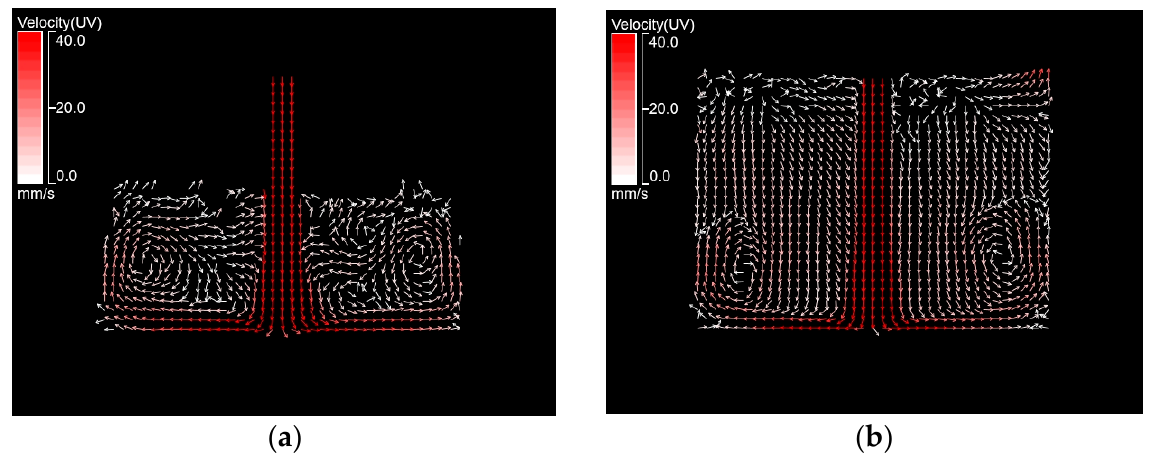
Figure 5. Mean velocity vectors under the initial temperature of 35 °C and flow rate of 770 mL/min: ( a ) the elapsed time of 90 s; ( b ) the elapsed time of 540 s.